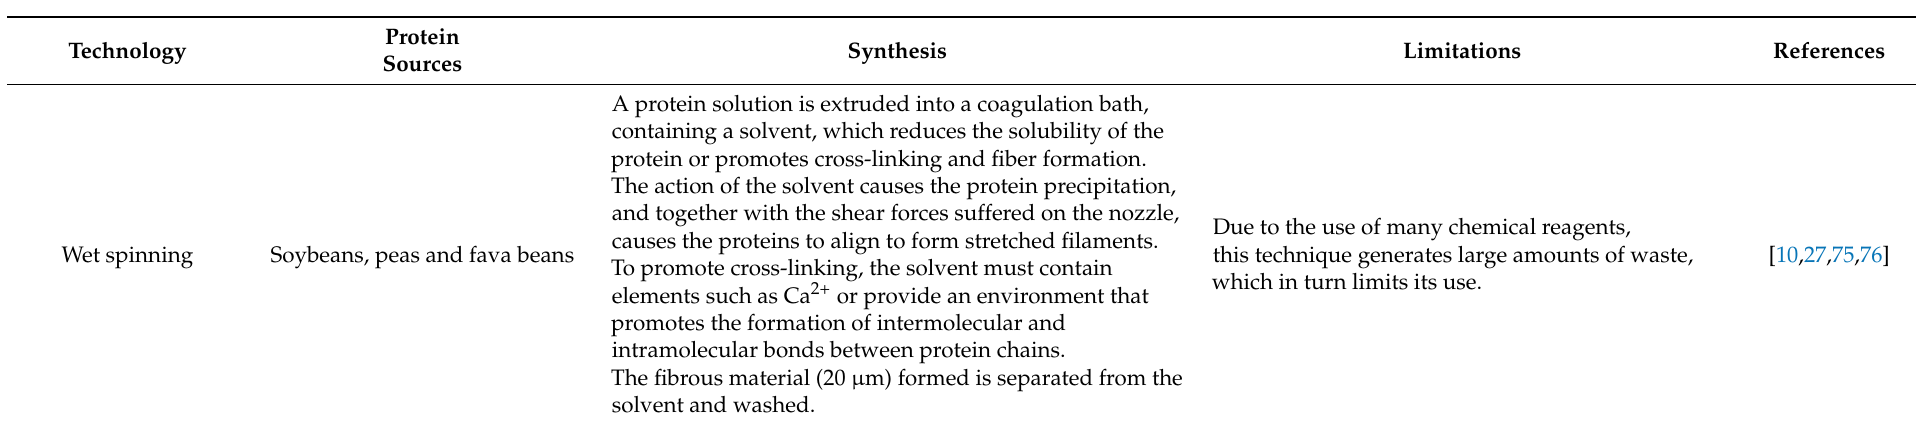
Table 3. Technological processes to produce meat